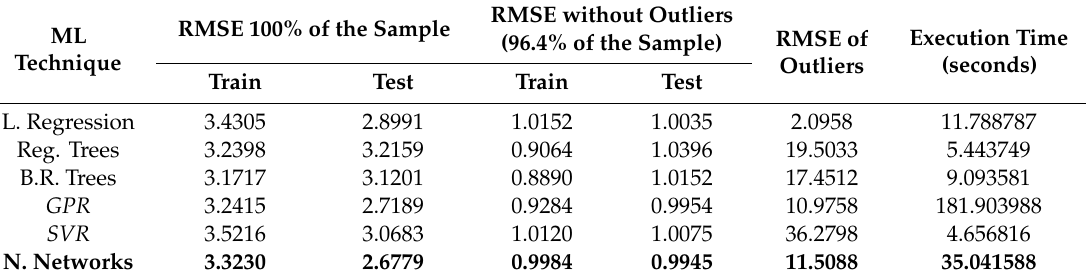
Table 17. SSDE-CTDI VOL results for Thorax protocol.